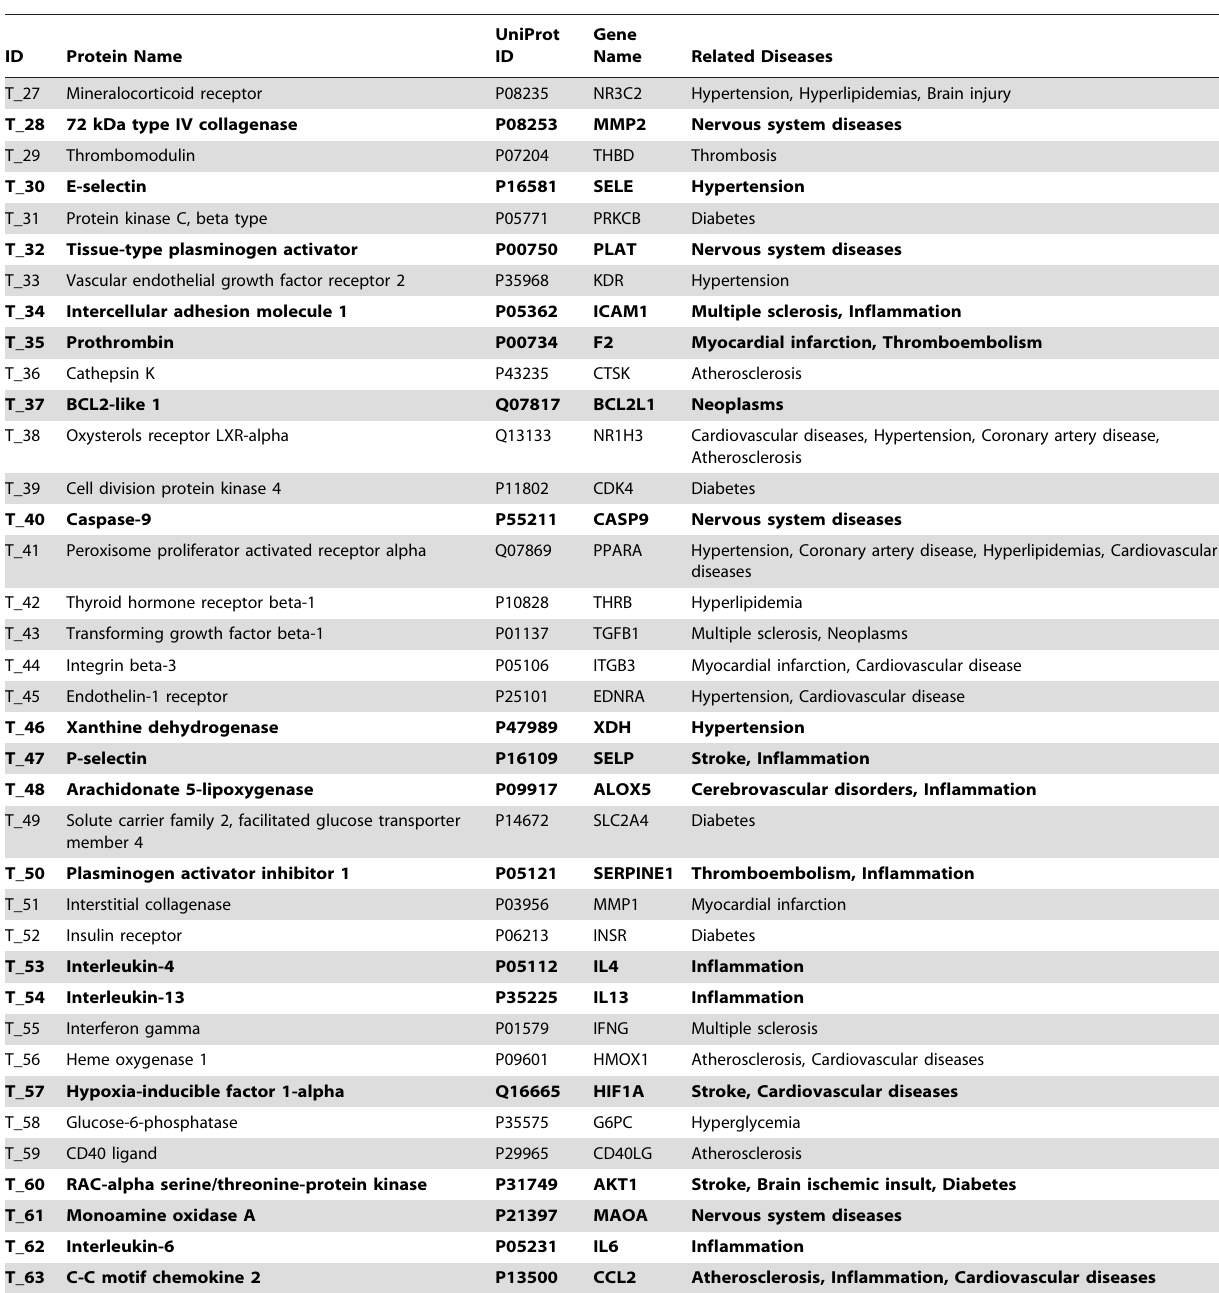
Table 3. The stroke-related targets of herbs and their corresponding diseases (Part